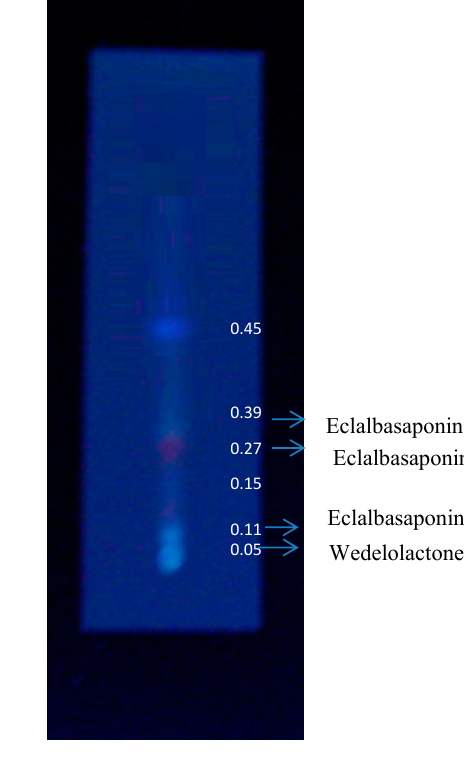
Figure 5. UPLC chromatogram profile of the column purified fraction of E. alba at 260 nm.